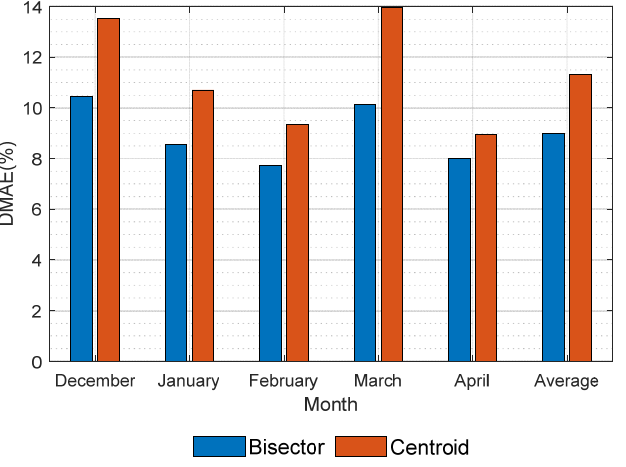
Figure 8. Estimation error of power generation with the different de-fuzzification methods.